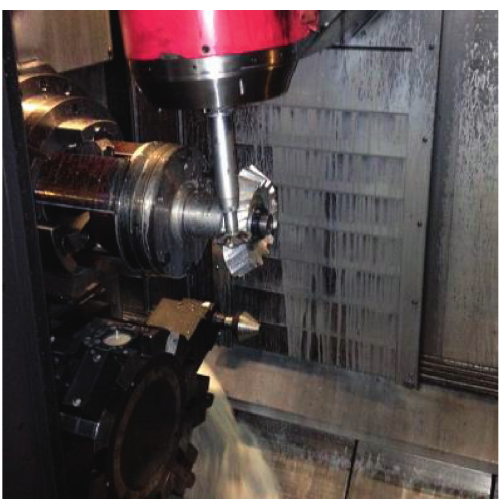
Figure 12: Gear rolling test